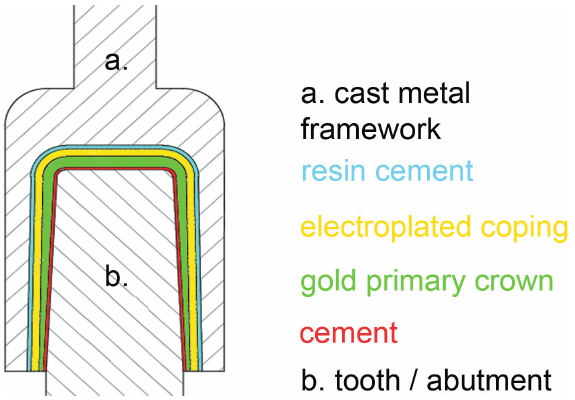
the fixation of the electroplated coping (yellow) in the cast metal framework (a); The conical crown (green) is fixed by resin cement (red) onto the specimen holder (b)